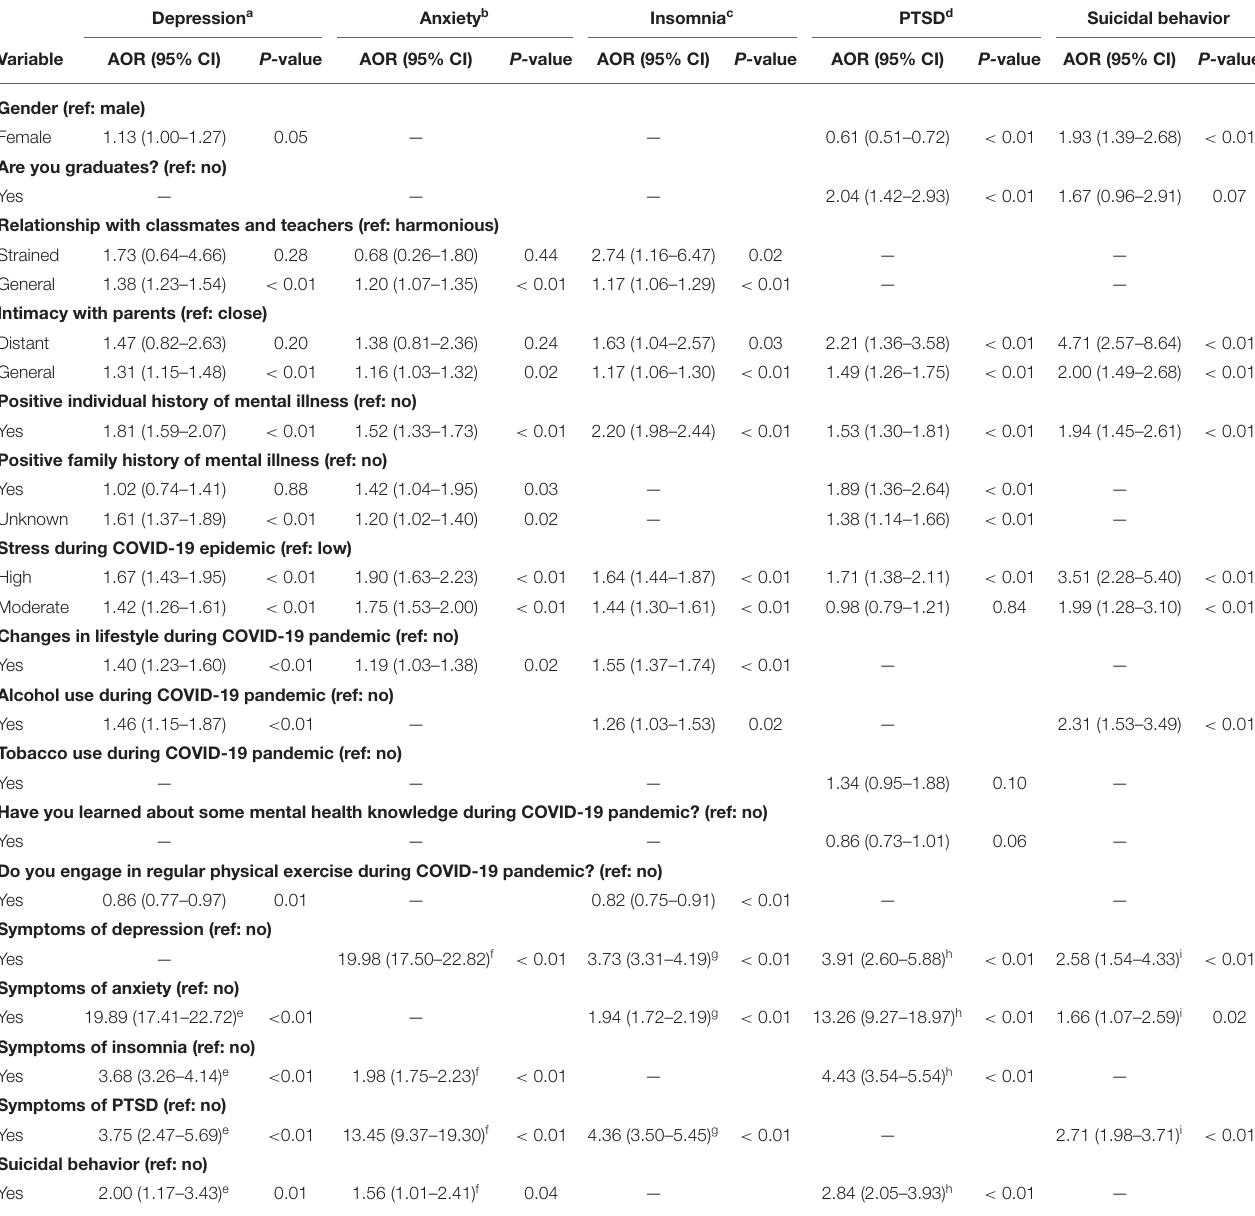
TABLE 3 | Multivariable regression analysis of risk factors associated with mental health symptoms and suicidal behavior. Depression a Anxiety b Insomnia c PTSD d Suicidal